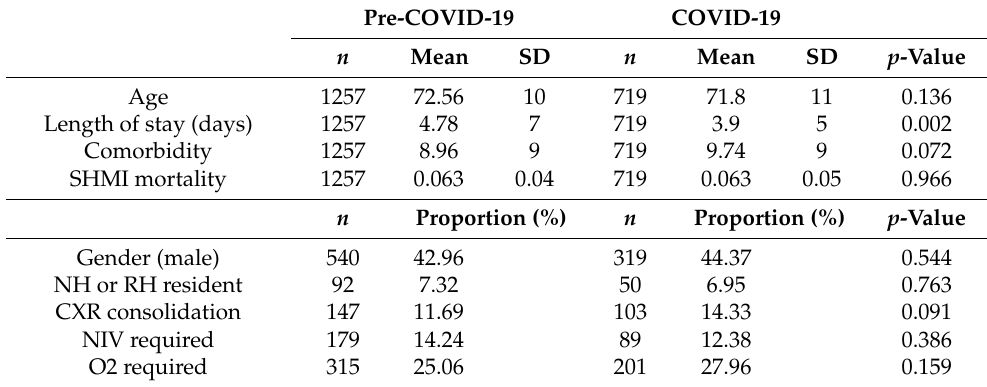
Table 2. Descriptive statistics: pre-COVID-19 period versus COVID-19 period.